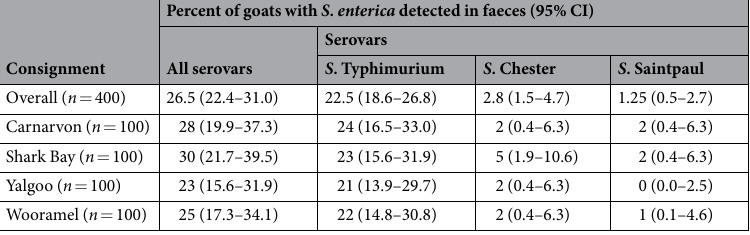
Table 2. Percent of rangeland goats ( n = 400) with Salmonella enteric a detected in faeces at slaughter in Western Australia showing breakdown by origin of consignment and serovar detected. Antimicrobial